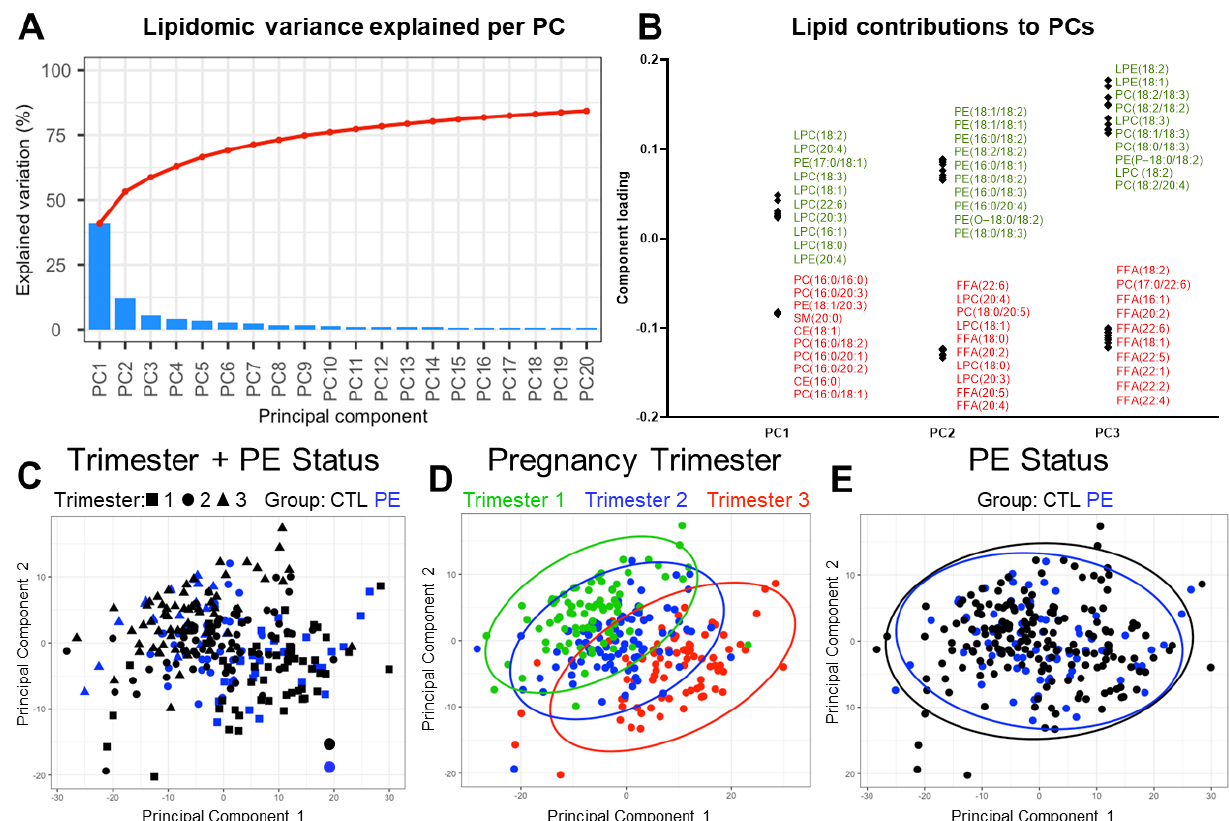
Figure 3. Unsupervised principal component analysis of plasma lipidomes from pregnant women with and without PE in the setting of obesity. ( A ) Scree plot showing the percent of lipidomic variance explained by each principal component. ( B ) Individual lipids which contribute most strongly to the first three principal components. The top 10 positive contributing lipids are shown in green and the top 10 negative lipids are shown in red. ( C – E ) Lipidomic data projected onto the first two principal components. Each data point represents a specific sample. Data are displayed by ( C ) trimester and group, ( D ) trimester, and ( E ) group. Ellipses indicate the 95% confidence ellipse of each group.